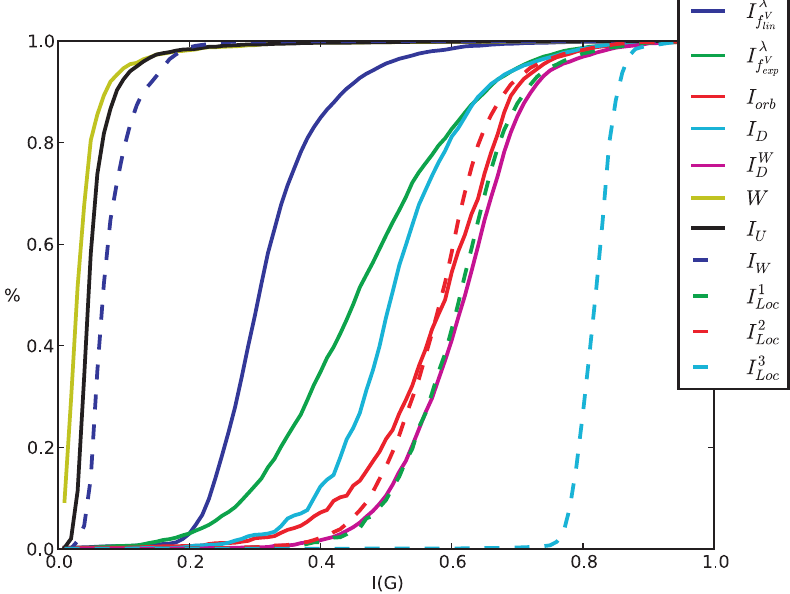
Figure 7. Cumulative Entropy Distributions for AG 3982. (reference label: cum_plot2).